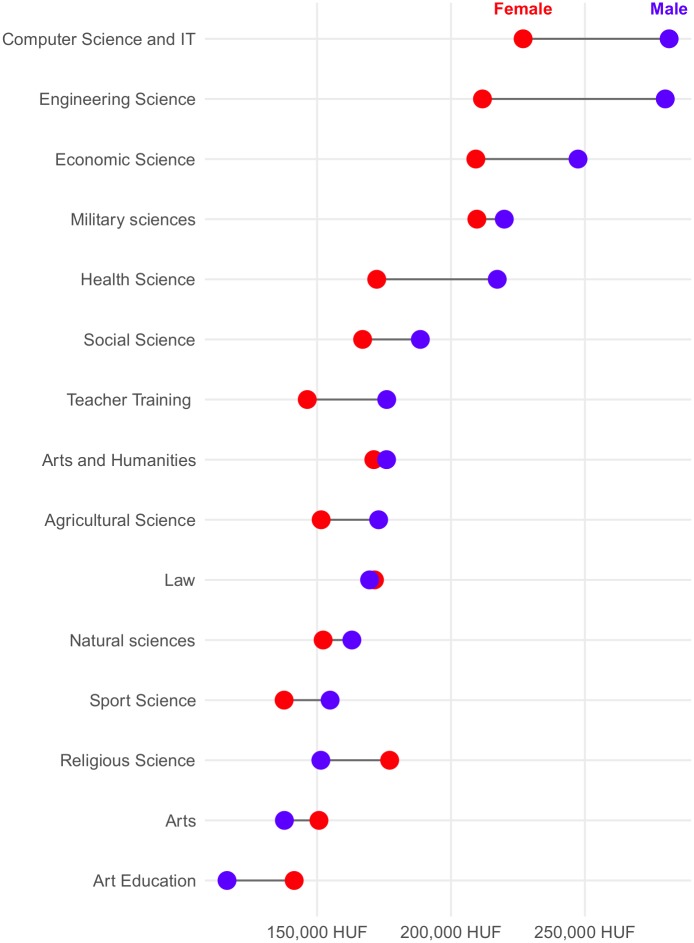
Gender pay gap grouped by education program areas.